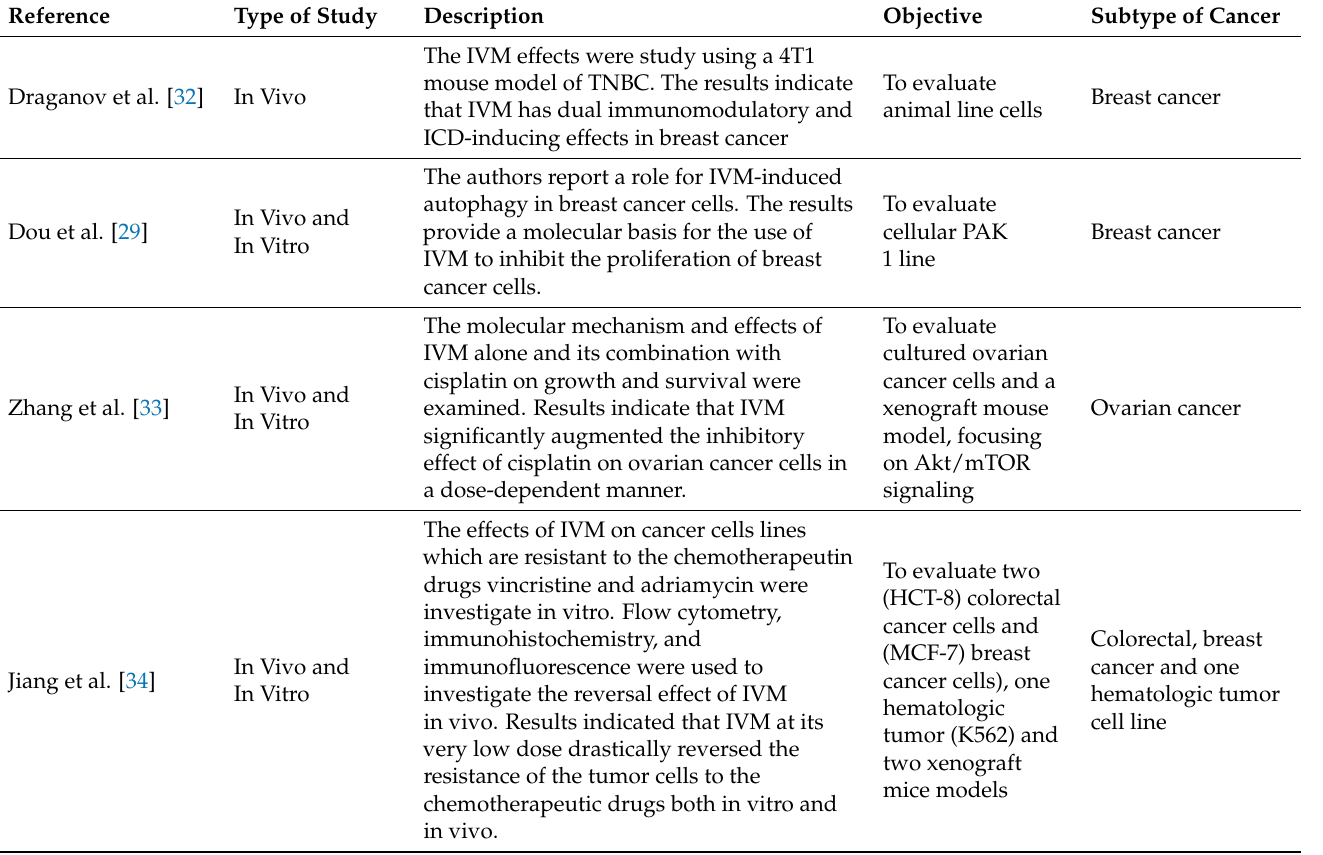
Table 1. Summary of the anticancer IVM